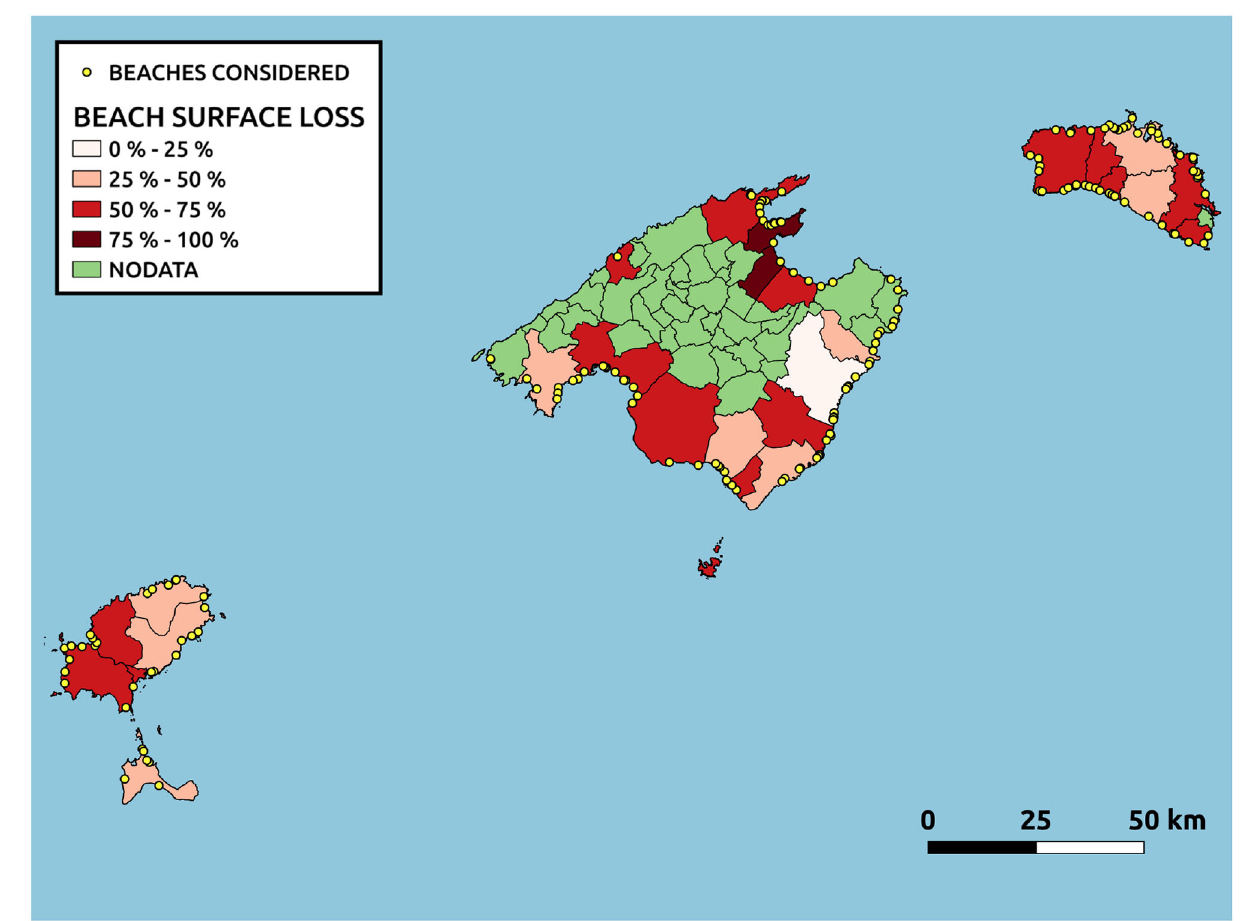
FIGURE 8 | Aerial beach surface loss by 2100 under the RCP8.5 upper limit of MSLR, relative to that of today, classified by municipality. Beaches considered are also